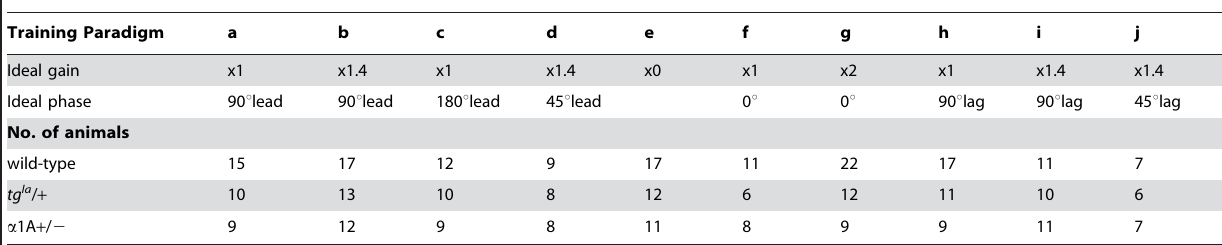
Table 1. VOR motor learning paradigms.